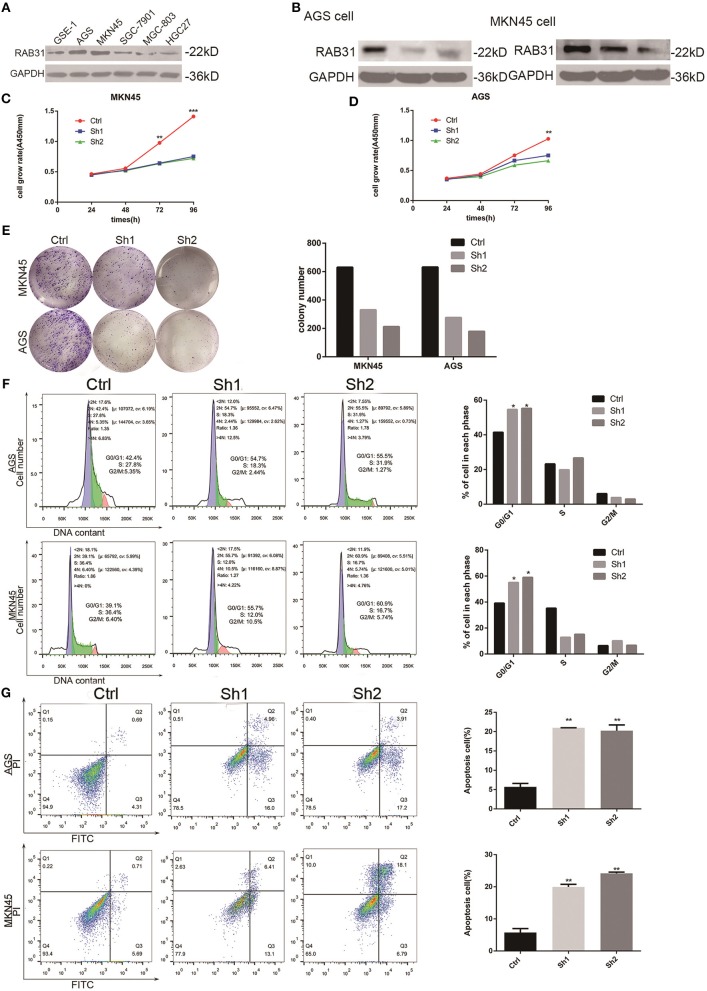
Depletion of RAB31 inhibits GC cell proliferation, blocks cell cycle progression, and promotes apoptosis in vitro. (A) Expression of RAB31 protein in six GC cell lines. (B) Western blot analysis of RAB31 in AGS and MKN45 cell lines after transfection of RAB31 siRNA; GAPDH was used as the control. (C,D) Viability of AGS and MKN45 cells after depleting RAB31 expression, as determined by the CCK8 assay. (E) Images from the colony formation assays in AGS and MKN45 cells are shown on the left; the average number of colonies formed in three experiments is shown by histogram on the right (P < 0.01). (F,G) Cell cycle and apoptosis were assessed by flow cytometry in AGS and MKN45 cell lines after knockdown of RAB31 expression; representative images are shown on the left and the results of triplicate assays are shown on the right. Results are shown as the mean ± SD (*P < 0.05, **P < 0.01, and ***P < 0.001).